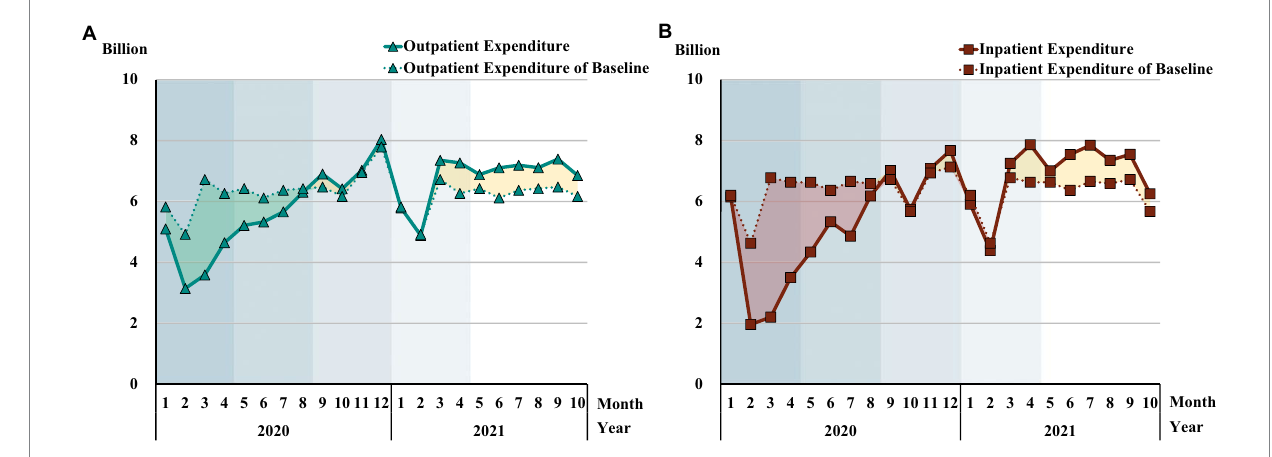
FIGURE 8 Comparison of the health expenditure pre and post COVID-19. Each shadow area denotes COVID-19 phase 1 to phase 5; (A, B) The green and red shading correspond to the part of higher expenditure for baseline than pandemic era; The yellow shading corresponds to the part of higher expenditure for the pandemic era than